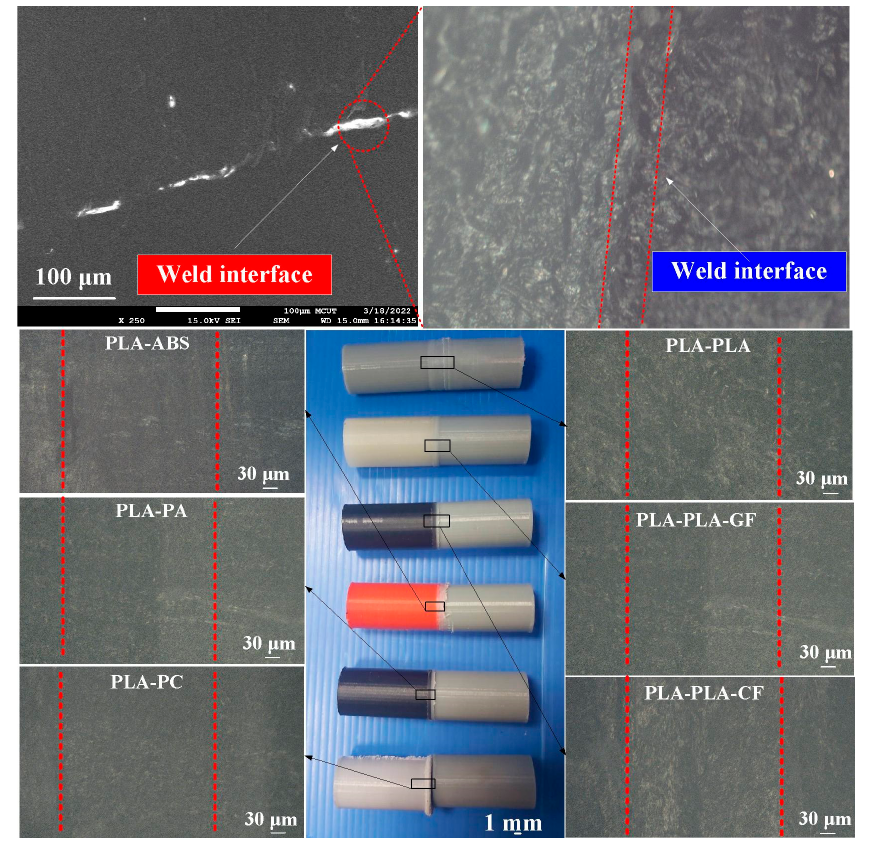
Figure 10. WI temperature as a function of welding time for the PLA to ABS rods in repeated exper- iments.